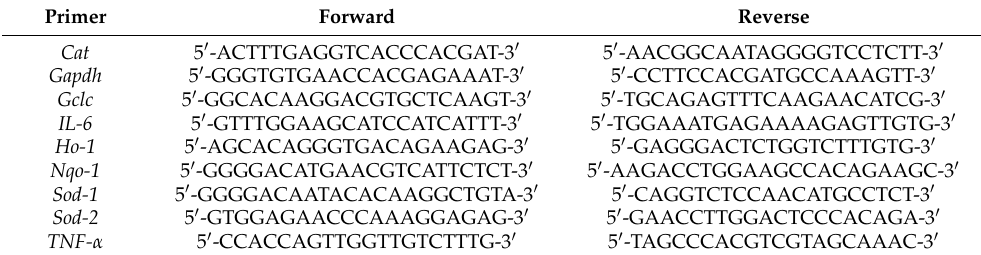
Table 2. List of primers used in the